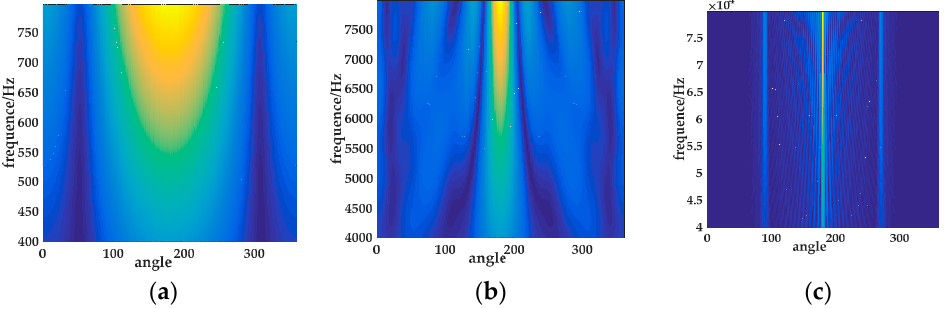
Figure 2. The amplitude intensities of the scattering function: ( a ) 400 − 800 Hz; ( b ) 4 − 8 kHz; ( c ) 40 − 80 kHz.